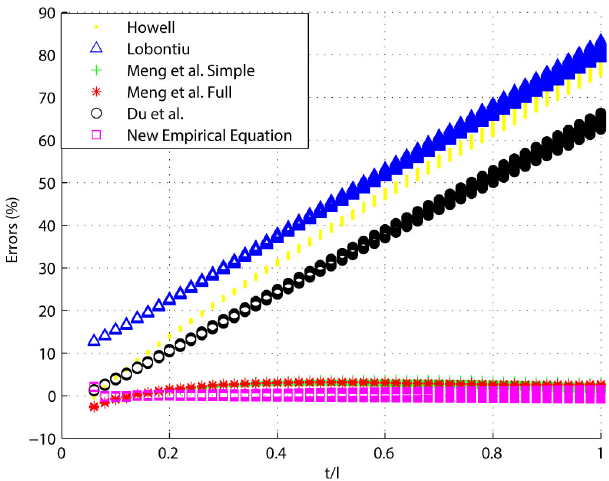
Figure 12. Comparison between FEA results and sti ff ness equa- tions results t / l = 0 . 5.